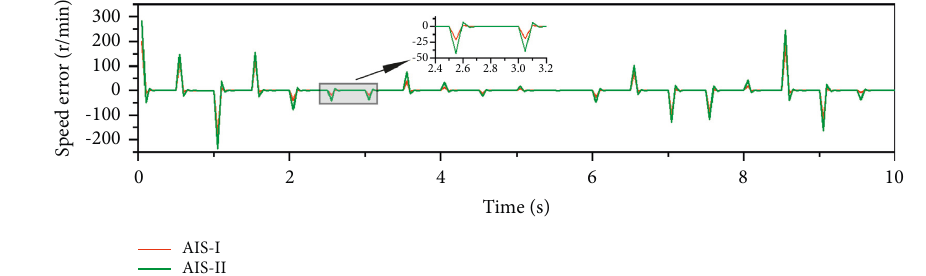
Figure 14: Simulated error between speed response and reference speed.